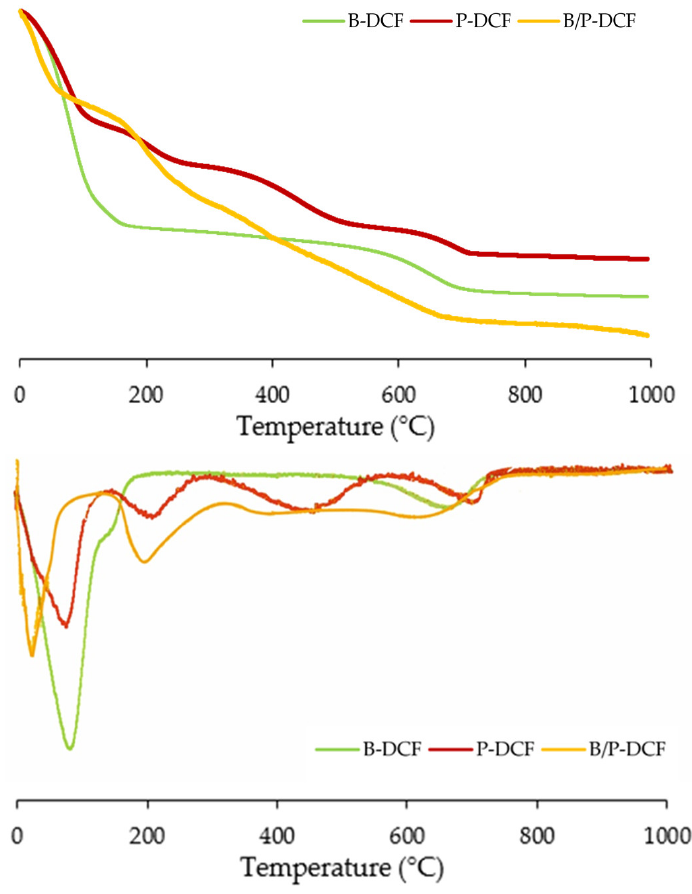
Figure 6. TGA ( top panel ) and DSC ( bottom panel ) of the gels (B-DCF, P-DCF, and B/P-DCF).